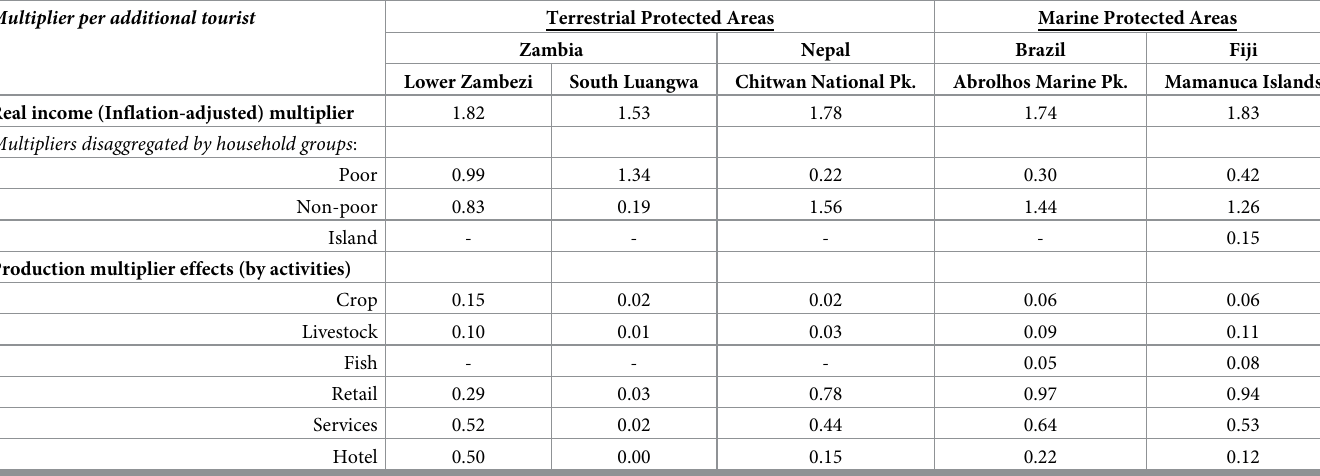
Table 2. Multiplier Effects of $1 of spending by tourists at protected